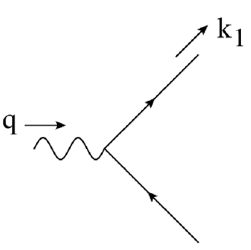
Figure 9 . The lowest order Feynman graph contributing to the partonic final state